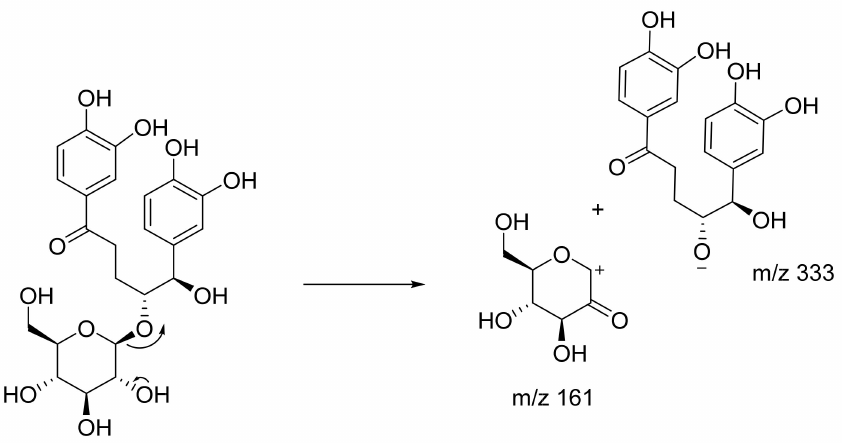
Figure 6. Proposed fragmentation pathway for curculigine.